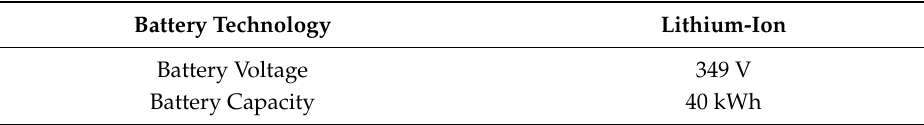
Figure 4. Monthly Average Wind Speed in the Region of Fez-Meknes. Table 1. Technical Specification of Nissan Leaf e+.